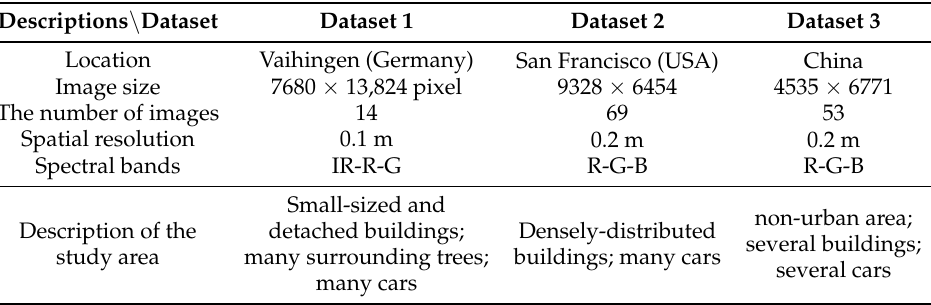
Table 2. The details of three datasets used in our